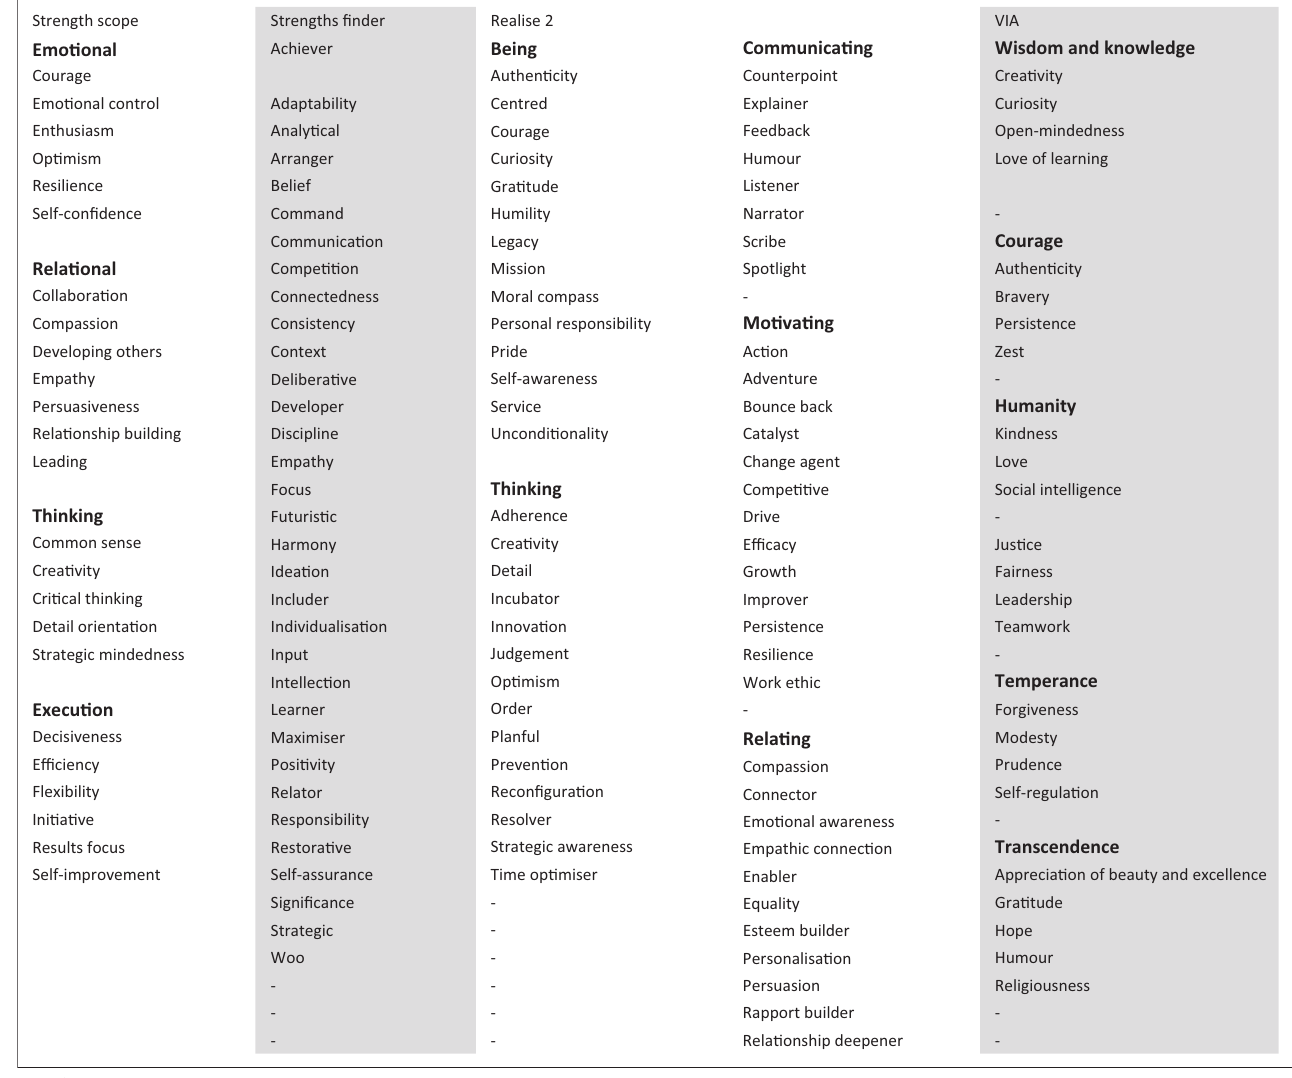
FIGURE 1: Comparison of strengths measurement instrument